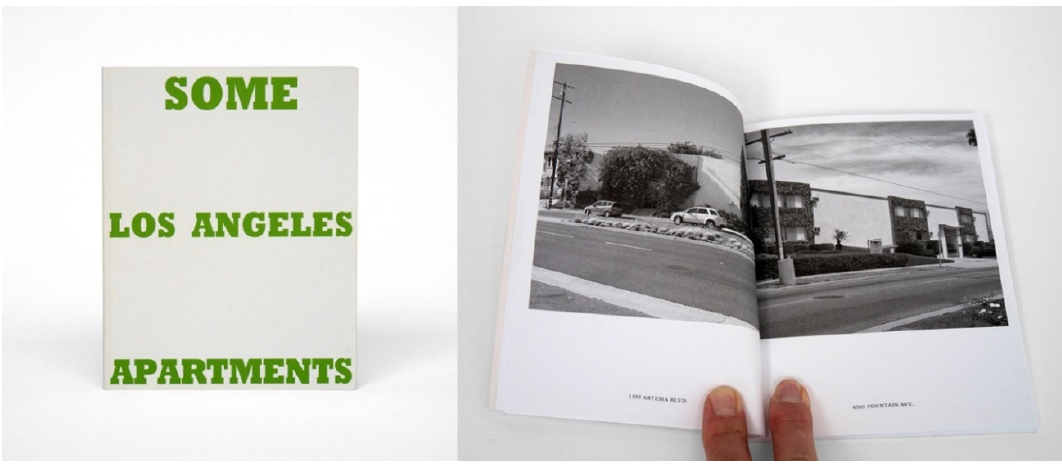
Figure 23. Eric Doeringer, Some Los Angeles Apartments , 2009.